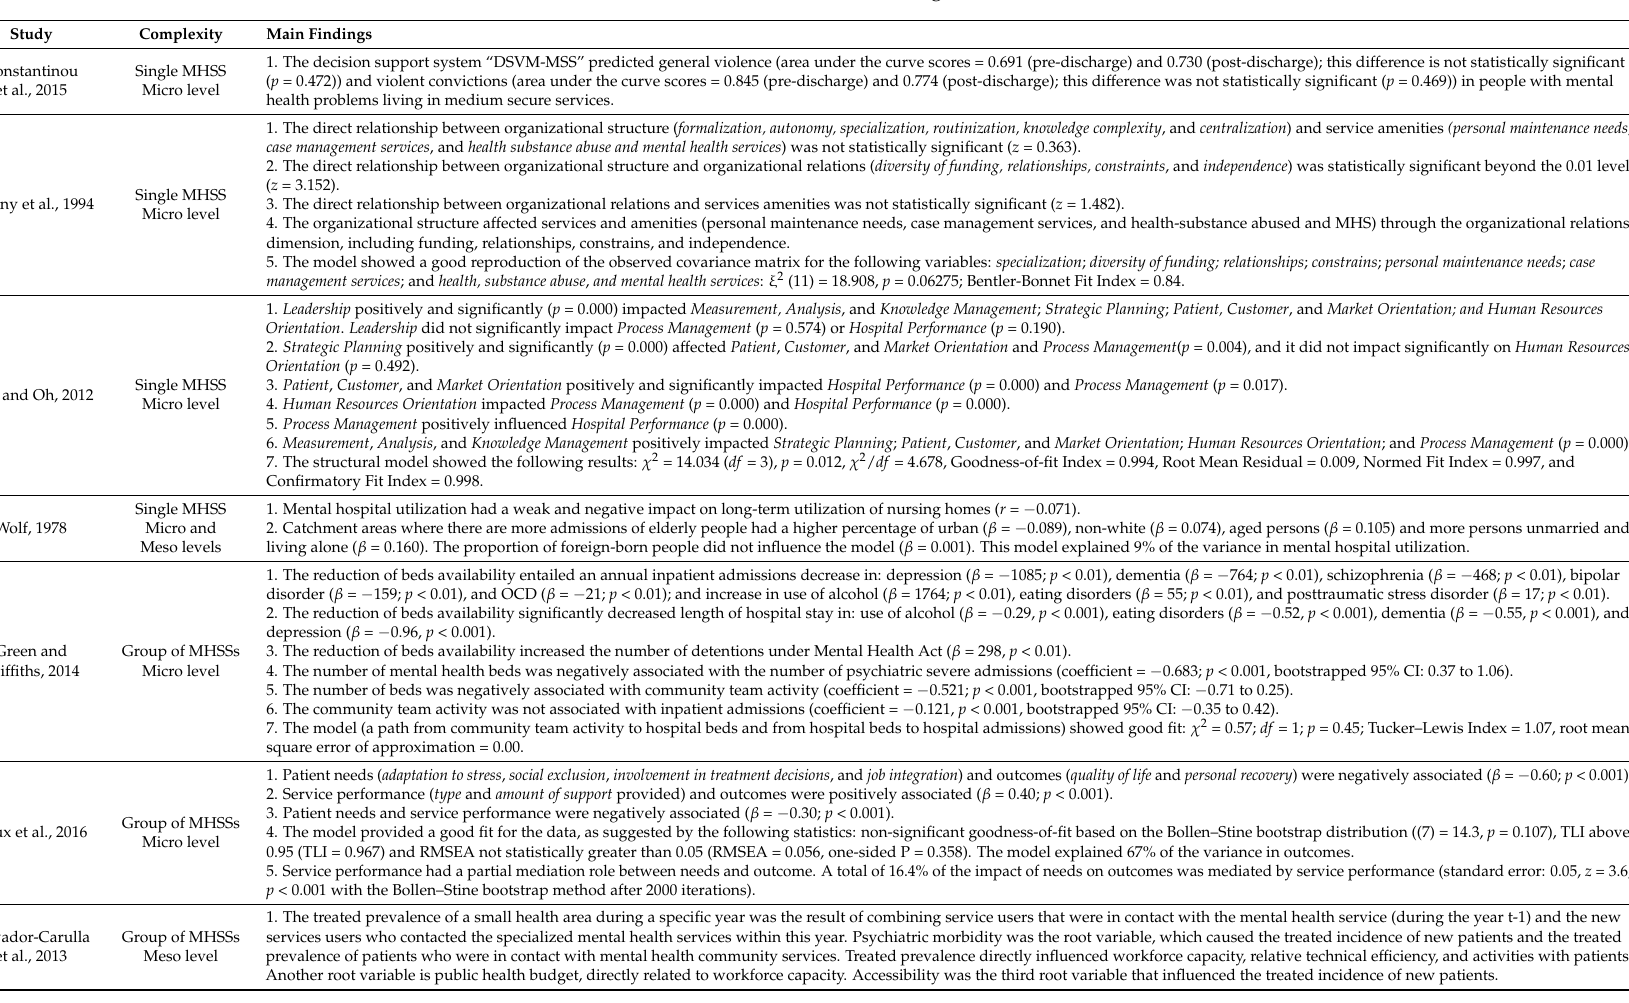
Table 5. Results: Main